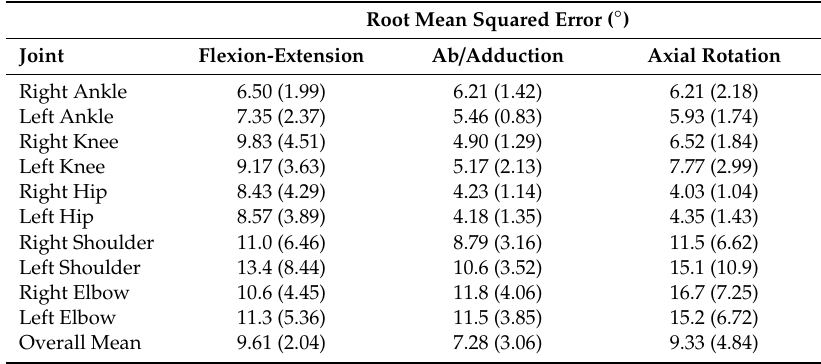
Table 4. Mean RMSE values V OPT vs. V IMU .